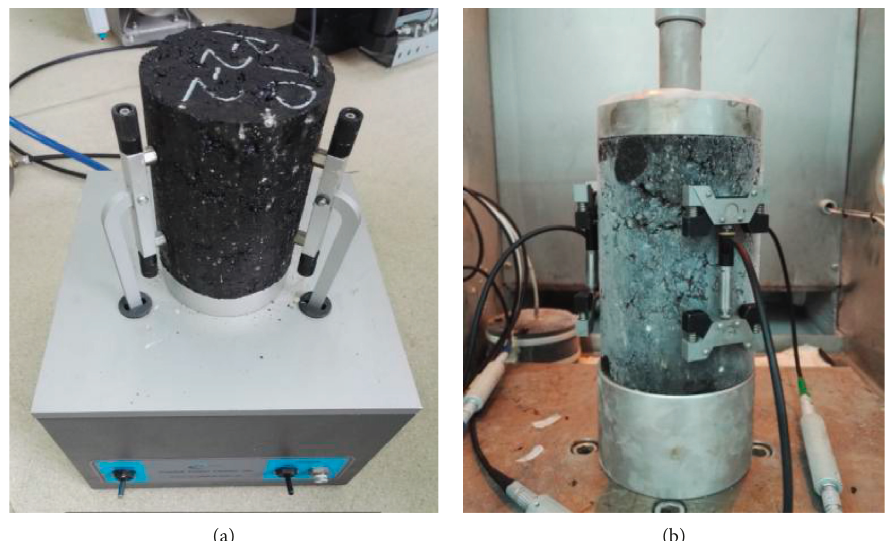
Figure 4: Adhesive and test of foam asphalt mixture specimens.